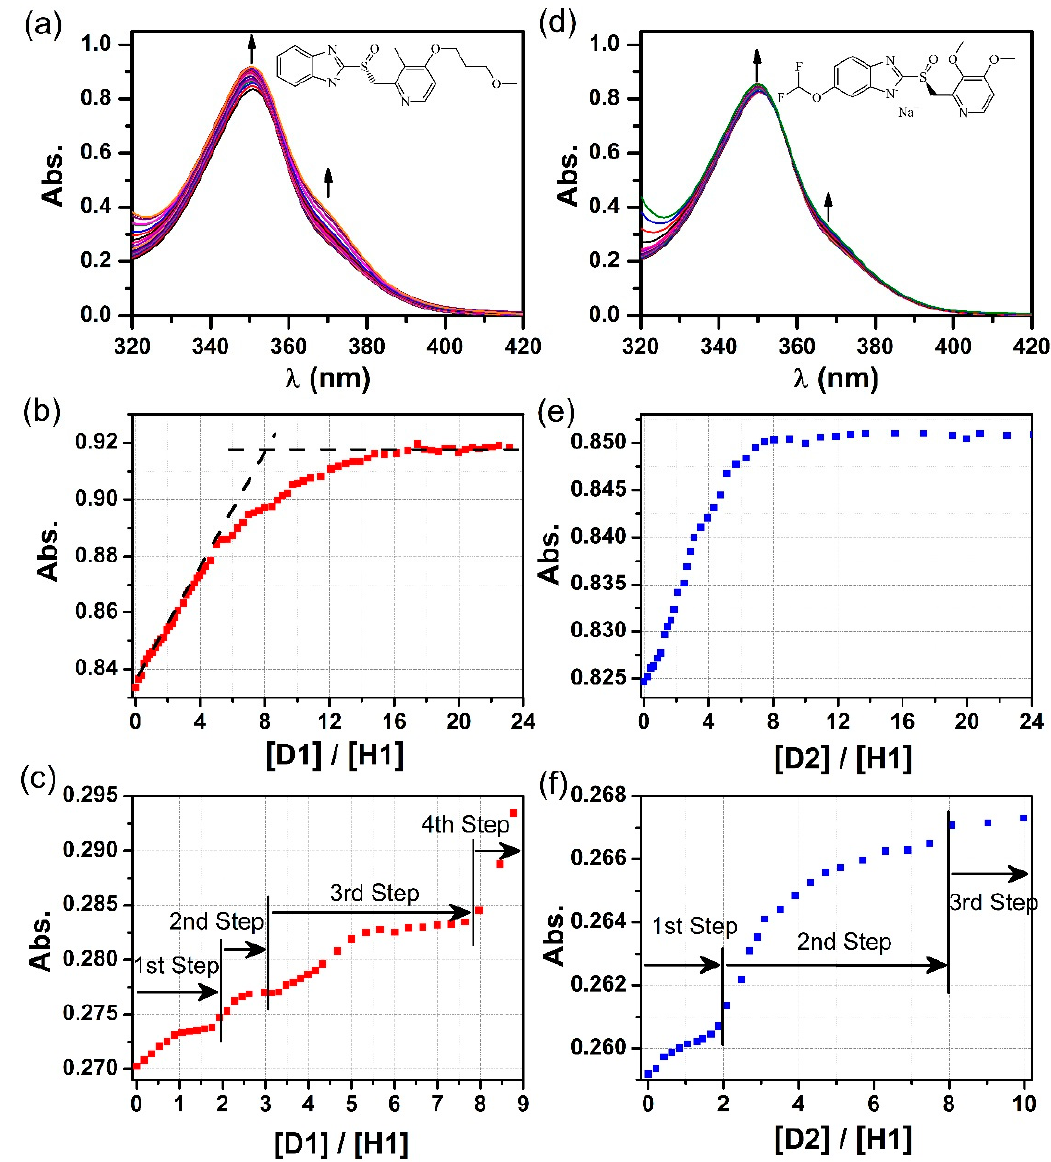
Figure 3. ( a ) UV-Vis spectra of host H1 upon titration with D1 , and plots of D1 / H1 molar ratio vs. absorbance at ( b ) 350 nm and ( c ) 370 nm based on the titration experiment. ( d ) UV-Vis spectra of host H1 upon titration with D2 , and plots of D2 / H1 molar ratio vs. absorbance at ( e ) 350 nm and ( f ) 370 nm based on the titration experiment.